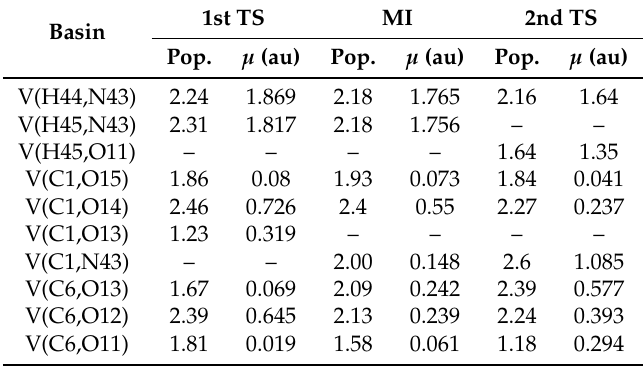
Figure 10. Combined ELF/NCI surfaces of the critical structures for Configuration C2 for Scheme 1d. Panels ( a – e ) show the reactants, TS1, MI, TS2, and products structures, respectively. The isovalue for ELF was 0.83 and for NCI was 0.5, with a color scale of − 0.05 au < sign( λ 2) ρ < 0.05 au. Table 4. ELF populations and first polar moment ( µ ) analysis for specific basins involved in the reaction in the water/IL mixture corresponding to Configuration C2, Scheme